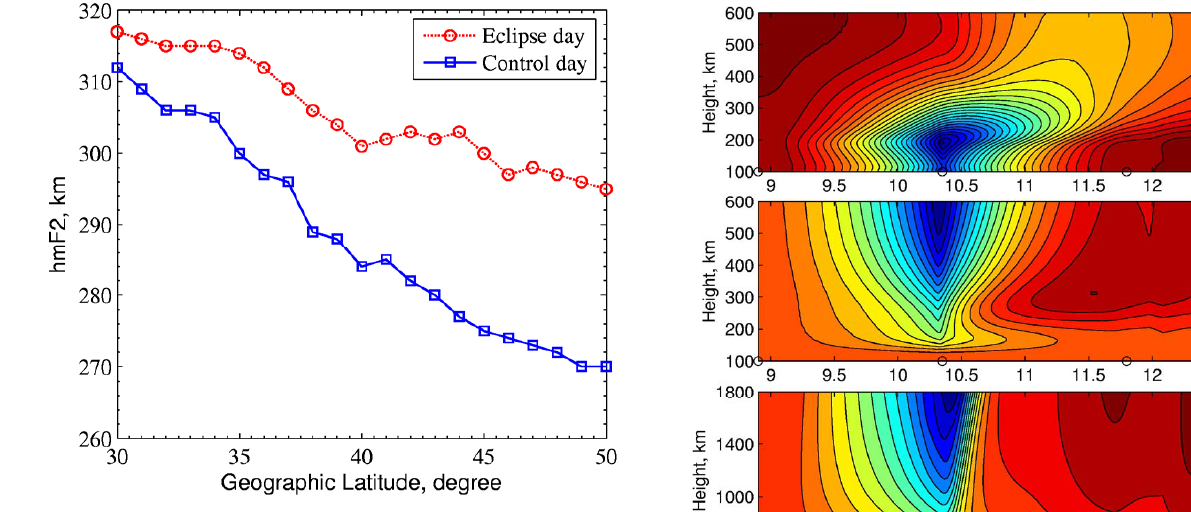
Figure 5. The values of the hmF2 at 1021 UT on eclipse day (dashed circle line) and on control 582 Fig. 5. The values of the hmF2 at 10:21 UT on eclipse day (dashed day (solid square line) versus geographic latitude. 583 circle line) and on control day (solid square line) versus geographic latitude.